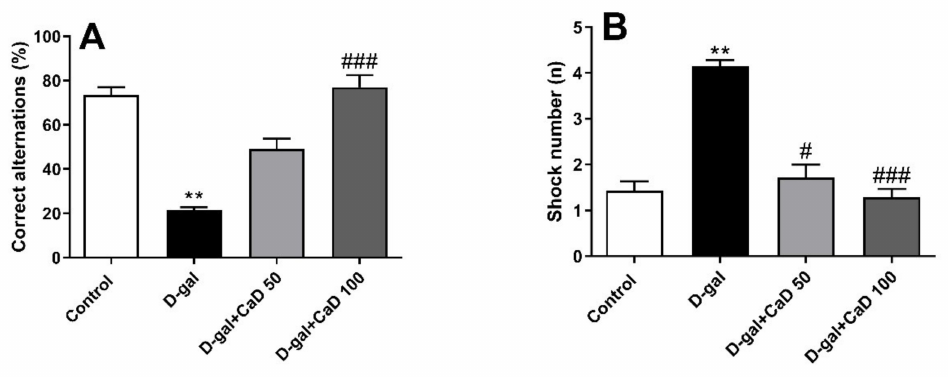
Figure 3. Effect of calcium dobesilate (CaD; 50 and 100 mg/kg, p.o.) on Y-maze ( A ) and shuttle box ( B ) in D-galactose (D-gal) treated mice. Values are mean ± SEM ( n = 7 in each group). ** p < 0.01 as compared to control group; # p < 0.05 and ### p < 0.001 as compared to D-gal treated group.